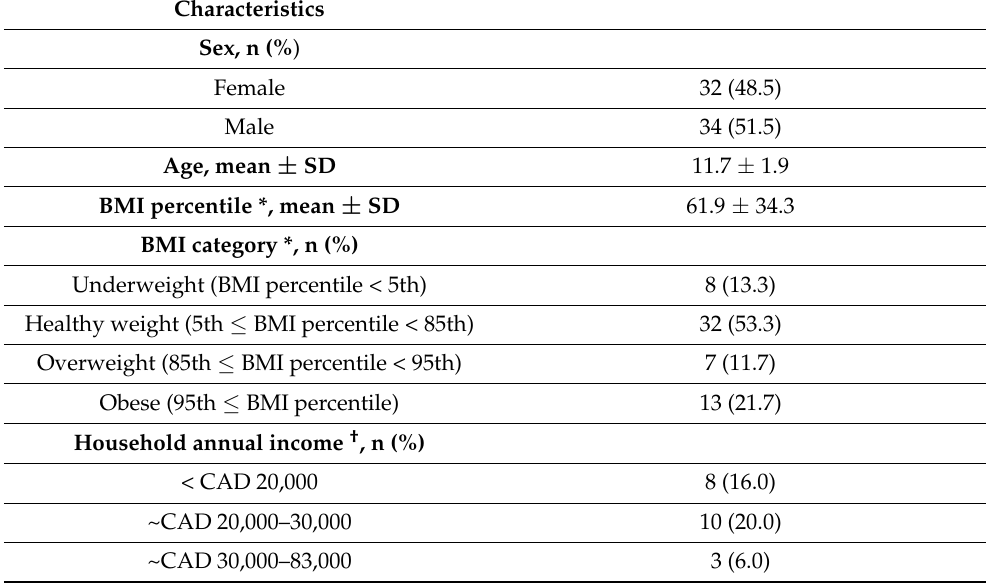
Table 1. Participant Demographics.